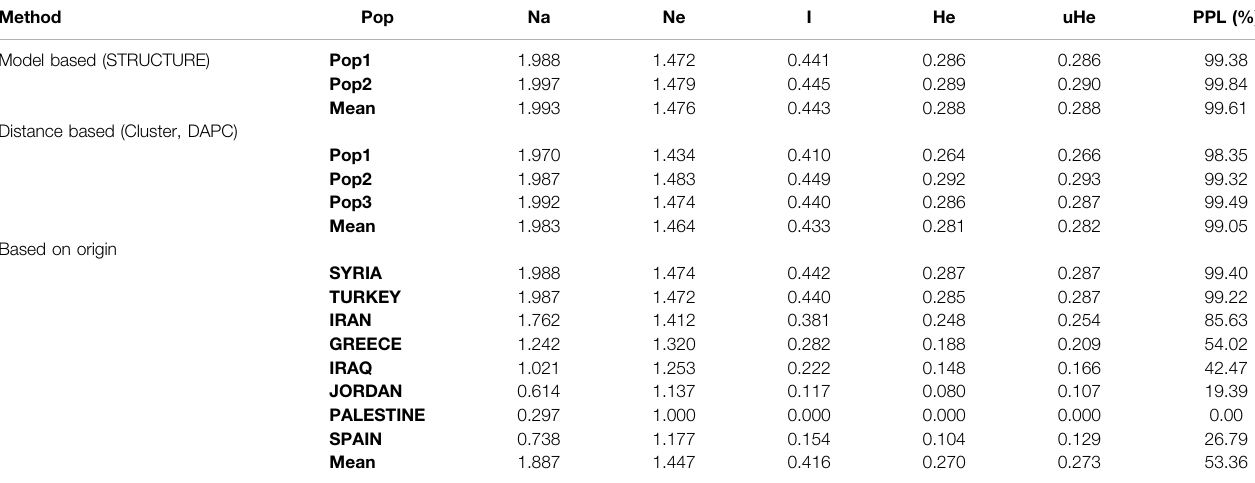
TABLE 4 | Mean of different genetic parameters: number of different alleles (Na), number of effective alleles (Ne), Shannon ’ s index (I), diversity index (He), unbiased diversity index (uHe), and percentage of polymorphic loci (PPL) in each of the two subpopulations.